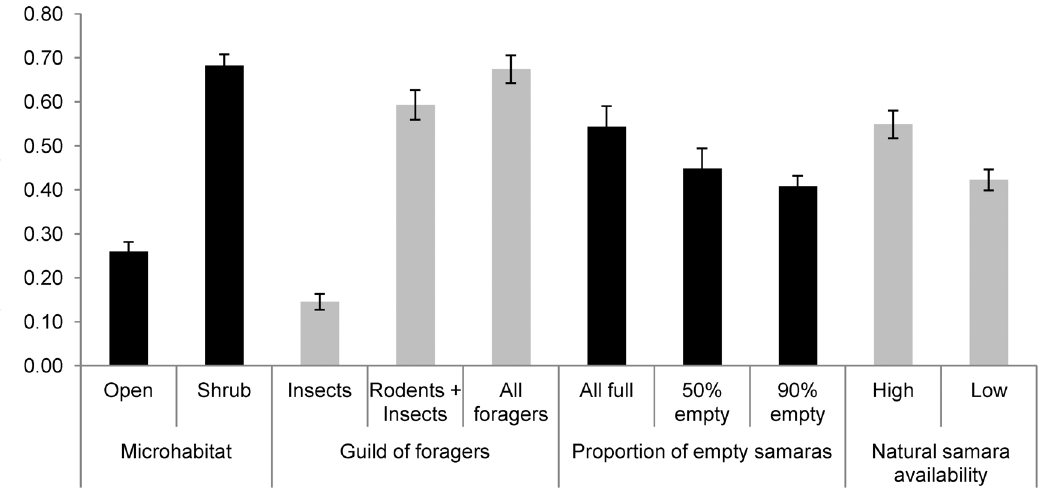
Figure 5. Proportion of seeds (full samaras) predated on the ground. Proportions are shown in relation to microhabitat of deposition, guild of foragers, proportion of empty samaras in the depot and natural samara availability.